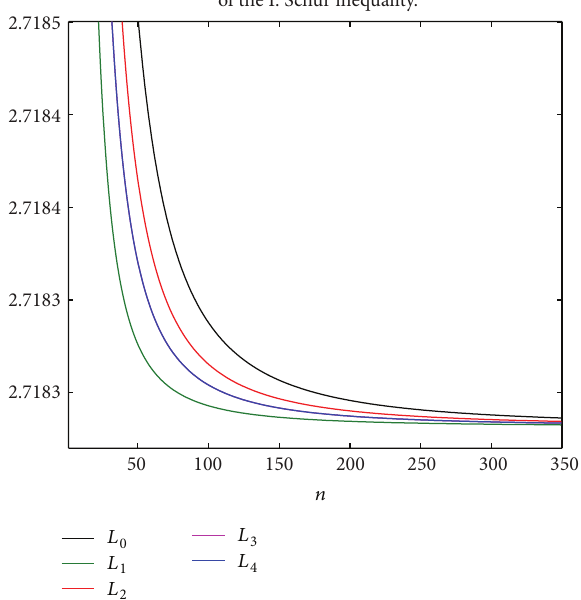
Figure 1: The variation trend of the different upper bounds value of the I. Schur inequality.